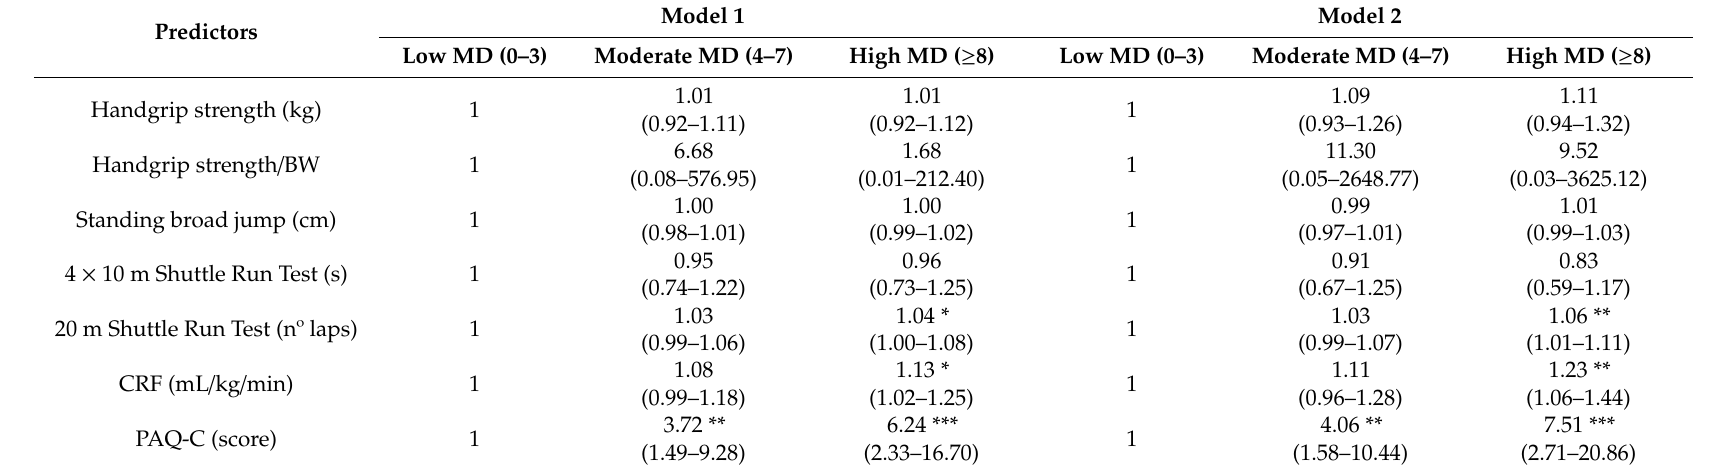
Table 3. Analysis of multinomial logistic regression for continuous variables of study according to the Mediterranean